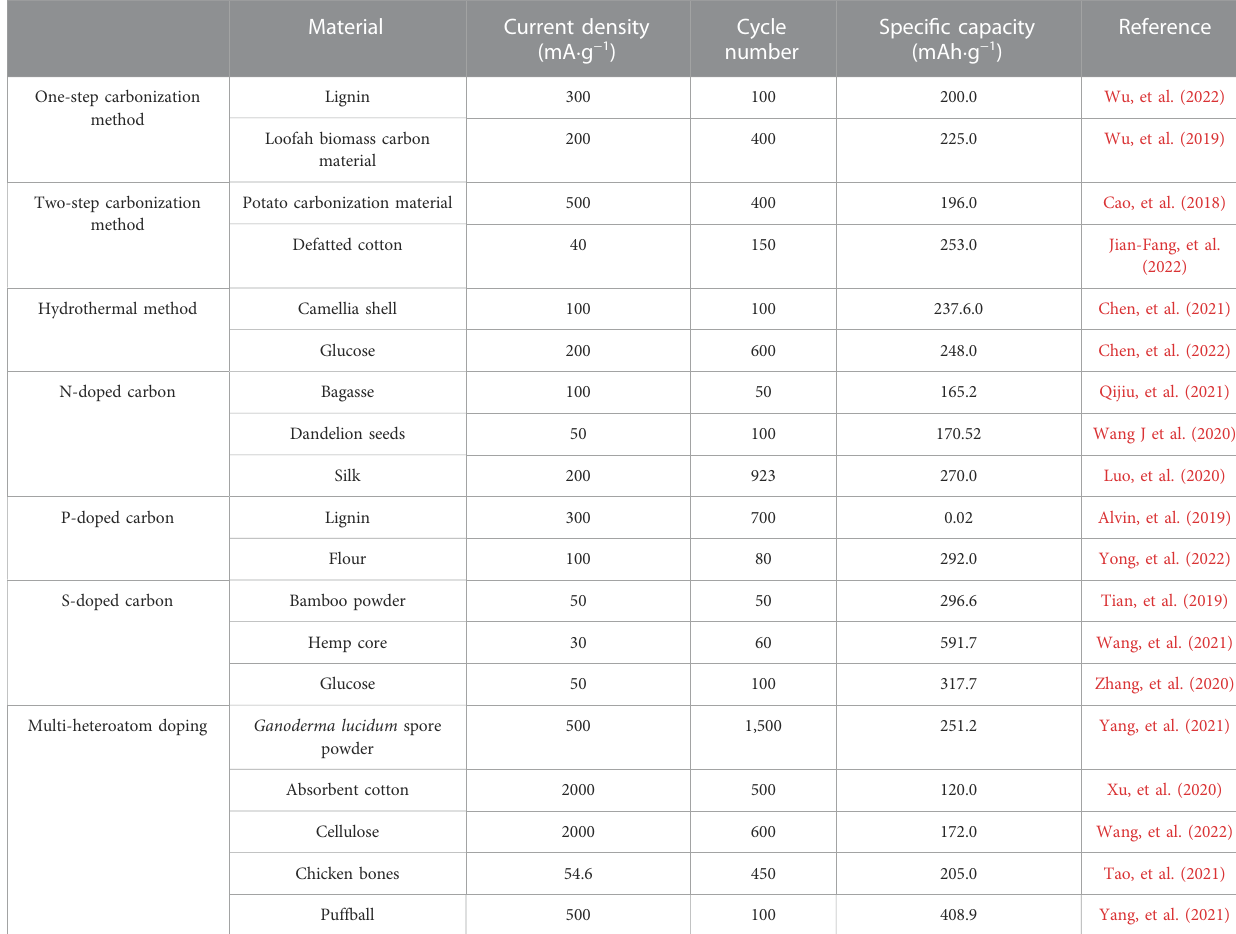
TABLE 1 Potassium-storage properties of the carbon-based anode materials were compared for different synthesis methods and modi fi cation